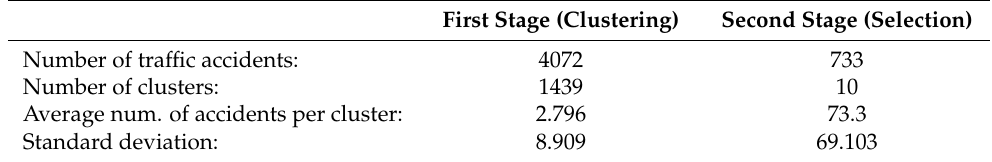
Table 1. A summary of the clustering and selection results obtained when the introduced algorithm was applied to publicly available data on traffic accidents with injuries or death that occurred in Belgrade during 2021.